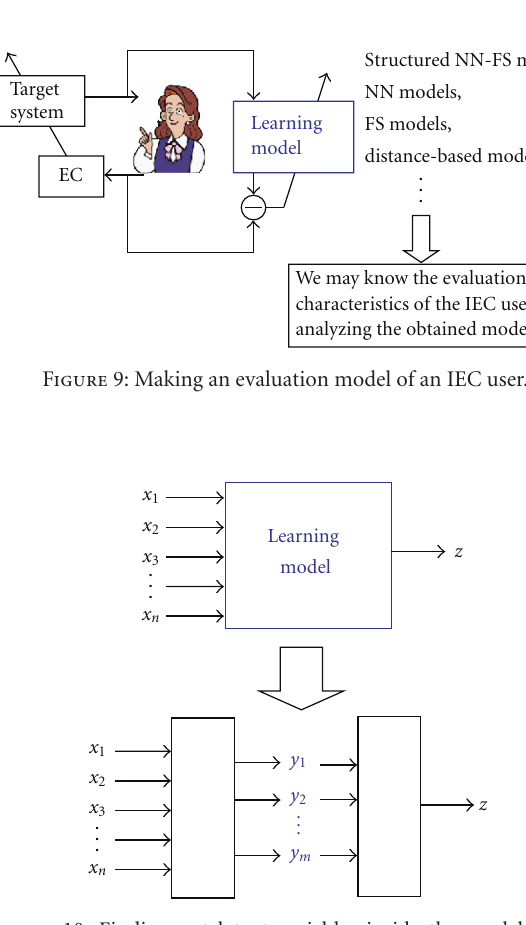
Figure 10: Finding out latent variables inside the model in the Step 1 that explains the output from the